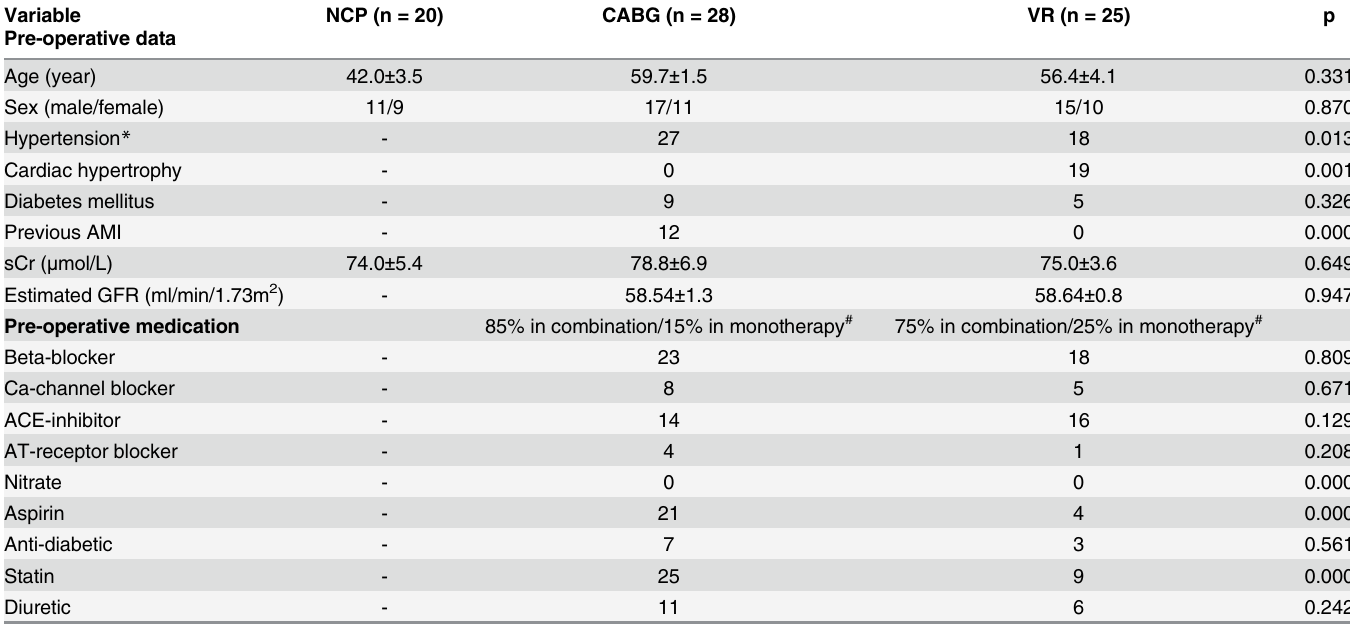
Table 1. Characteristics of the patients and medications.